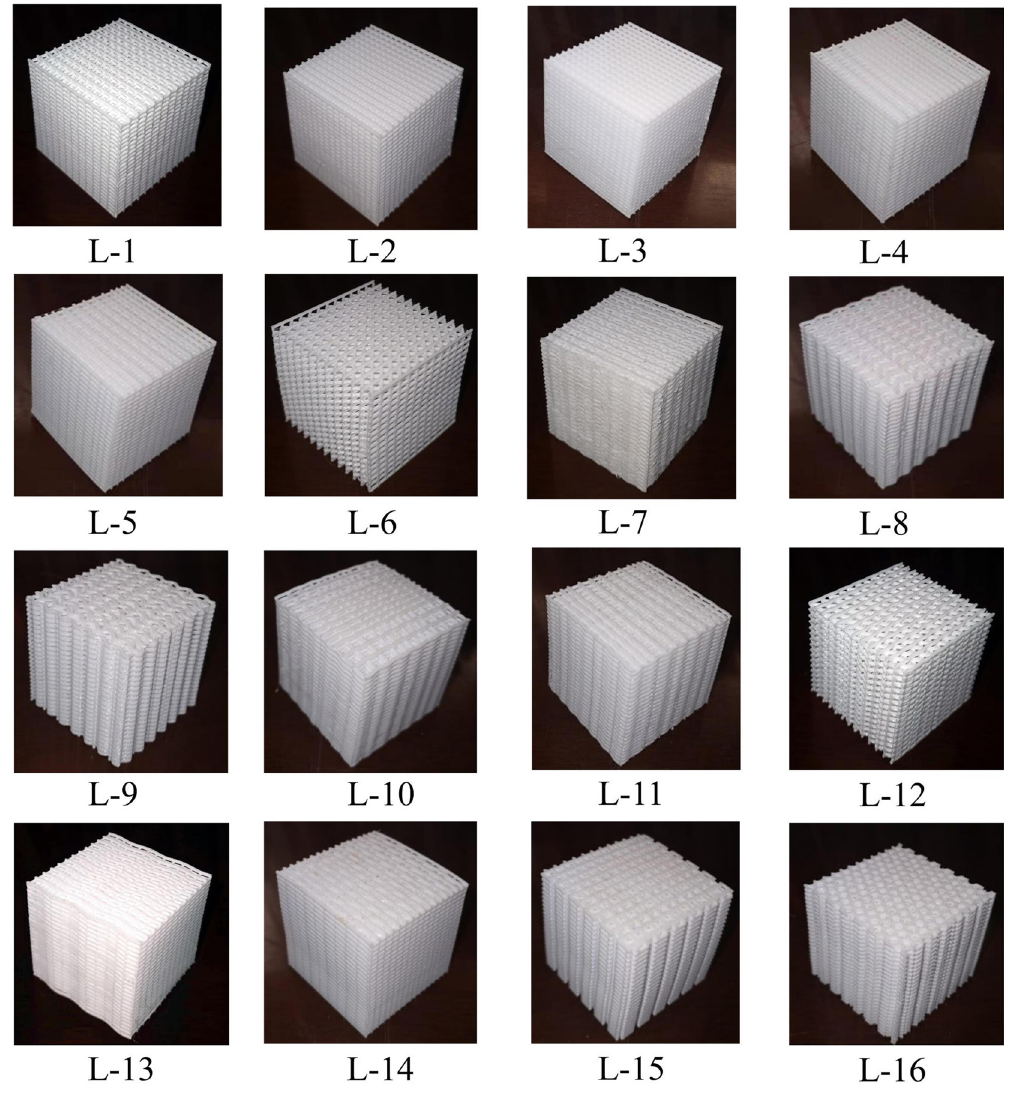
Figure 2. Cubic lattice specimen fabricated by 3D printing.